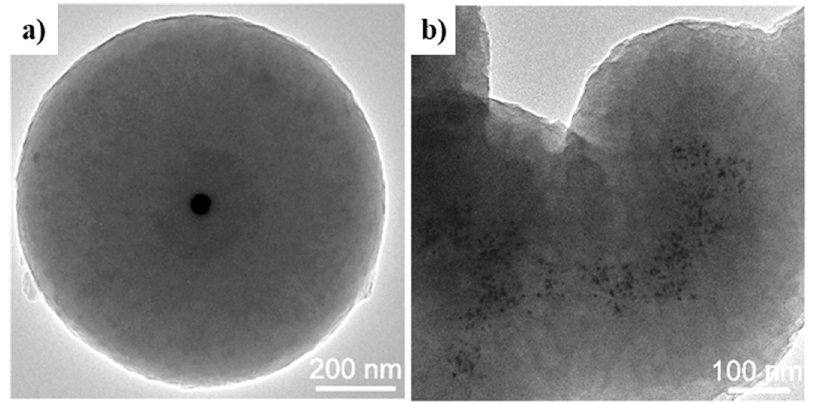
Figure 9. TEM image of ( a ) 0.38 wt% 50 nm Au NP (dark middle circle) and ( b ) 3.8 nm Pt NPs within the COF. Reprinted with permission from [58]. Copyright (2017) American Chemical Society.